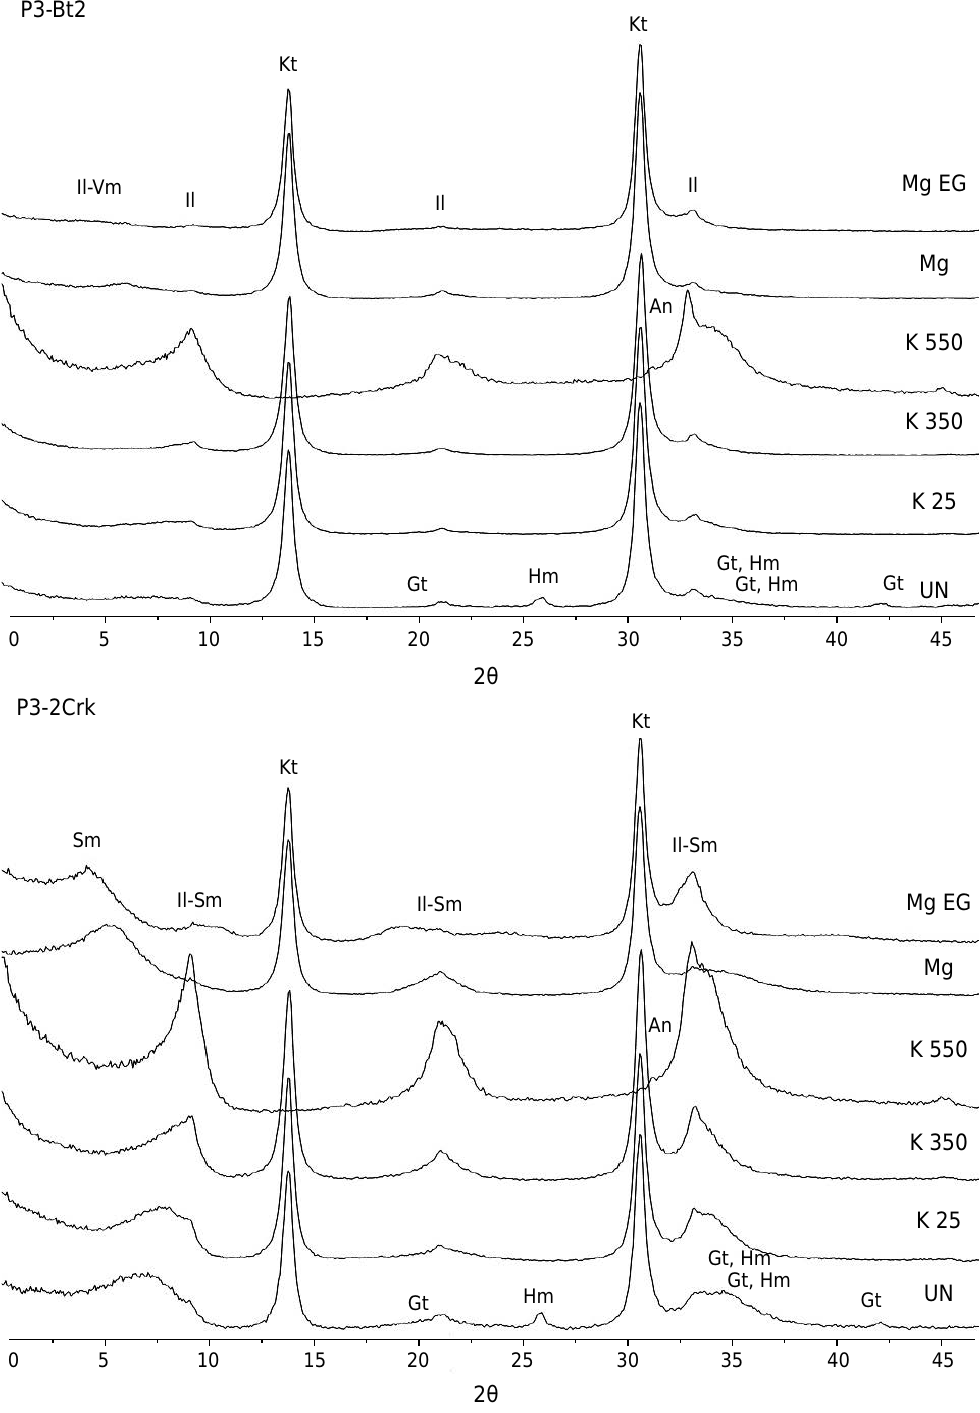
Figure 4. Diffractograms of the clay fraction of soil profile 3 (P3), Bt2 and P3-2Crk horizons. Smectite (Sm), Illite (Il), Kaolinite (Kt), Goethite (Gt), Hematite (Hm), Vermiculite (Vm), Anatase (An).Untreated total sample (UN), iron-free sample saturated with magnesium (Mg) and solvated with magnesium and ethylene-glycol (MgEG), iron-free sample saturated with potassium at room temperature (K25), and after heating at 350 °C (K350) and 550 °C